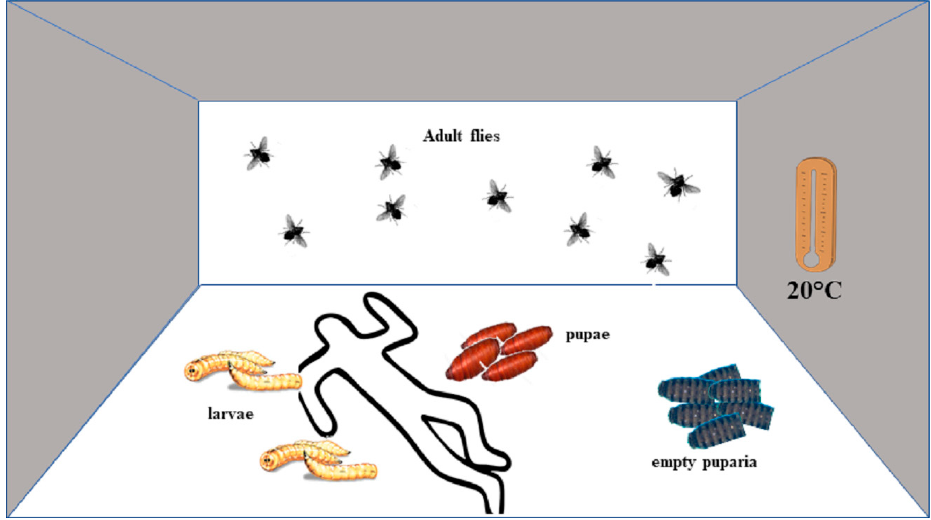
Figure 1. An exemplary PMI min determination using a fictitious case. The dead body was discovered in an apartment (20 °C ambient temperature), and only larvae, pupae, and empty puparia of one single species, the blow fly Calliphora vicina , were found on the body and its surroundings. In order to determine the PMI min , the most advanced stage of its development will be of relevance. In the present case, these are empty puparia. Since there is no current method to narrow this down with respect to the time of hatching, the entomologist will assume that the flies hatched immediately before the body was found in order to determine a reliable PMI min . There is a risk that this may lead to an underestimation of the time period. According to, e.g., Marchenko [11], C. vicina needs about 21 days to complete a complete development cycle at a temperature of 20 °C. These 21 days would be the PMI min in the present case, based just on the immature specimens (larvae, pupae) and remains (empty puparia). However, there are hundreds of adult C. vicina in the apartment. Thirty to forty specimens are captured, and by using various techniques (see below), their age is estimated to be 15–17 days. Based on the assumption that the animals have developed on the cadaver, this now means that we are giving a PMI min of 36 days in the entomological report (21 days development of larva and pupa plus 15 days aging of the fly).